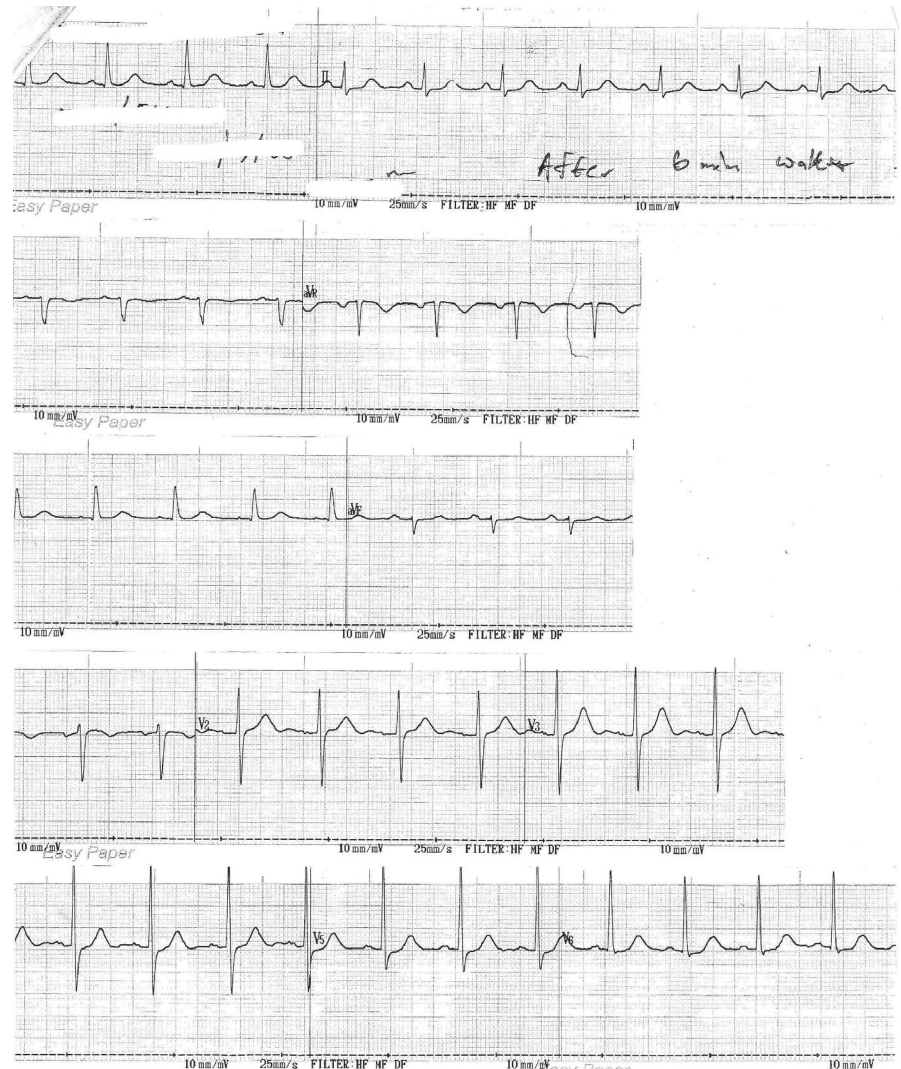
Figure 3: Electrocardiogram taken at the tertiary-care center after treatment showing normal